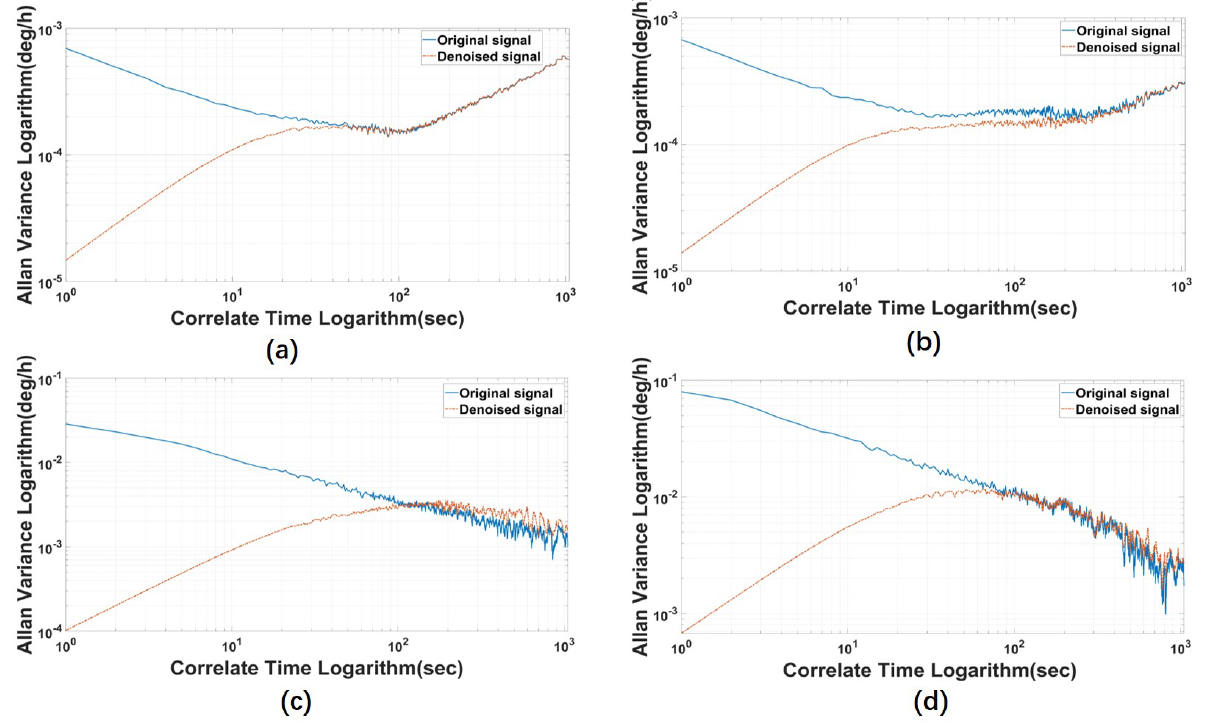
Figure 11. Allan variance of different denoising results of ICELMD, ( a , b ) are collected by different gyros, and ( c , d ) are collected by MPU6050.